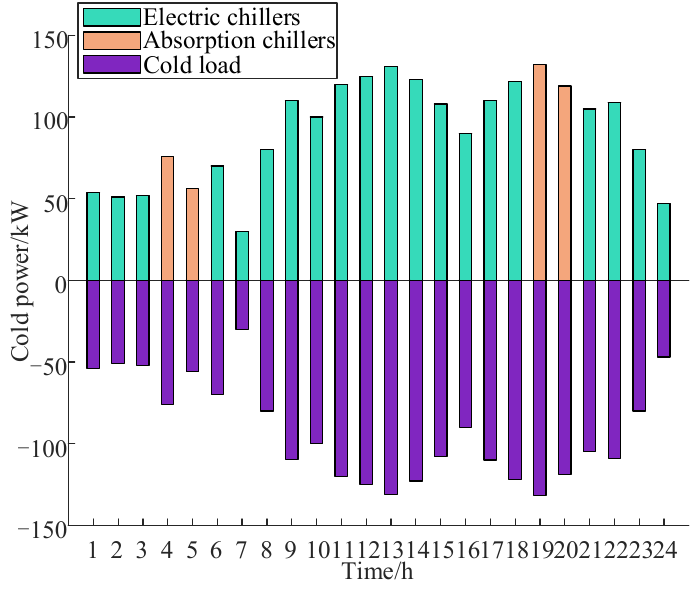
Figure 5. Cold power optimization diagram.